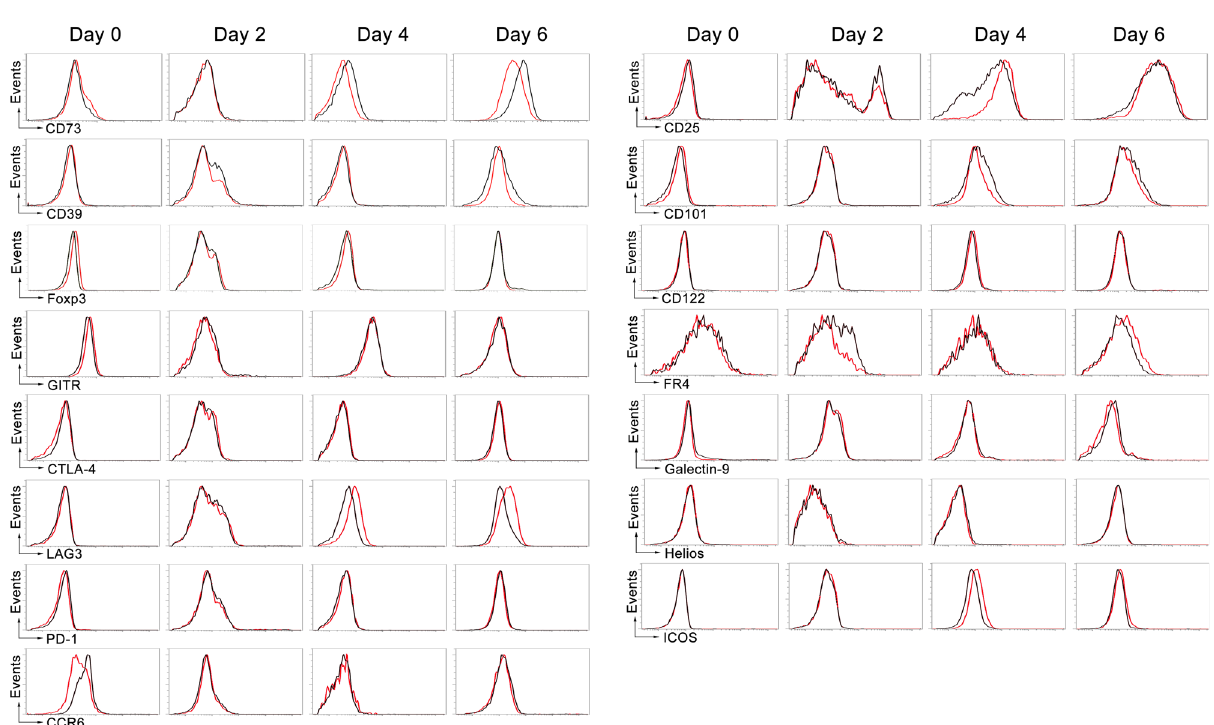
Fig. 3 Regulatory signature of CD8 + T cells stimulated via TCR without CD28 costimulation. Naïve CD8 + T cells (3 × 10 6 /mL) from spleens of CD28KO (black) and CD28WT (red) mice were sorted and stimulated with anti-CD3/28 antibodies. On days 0, 2, 4, and 6 after stimulation, cells were harvested and subjected to fl ow cytometric analysis for the expressions of CD73, CD39, Foxp3, GITR, CTLA-4, LAG3, PD-1, CCR6, CD25, CD101, CD122, FR4, Gelactin-9, Helios and ICOS. The data presented are representative of one of the three independent